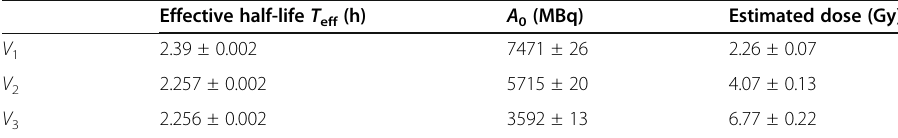
Table 4 Estimation of effective half-life, activity at infusion time, and corresponding local absorbed dose for volumes V 1 , V 2 , and V